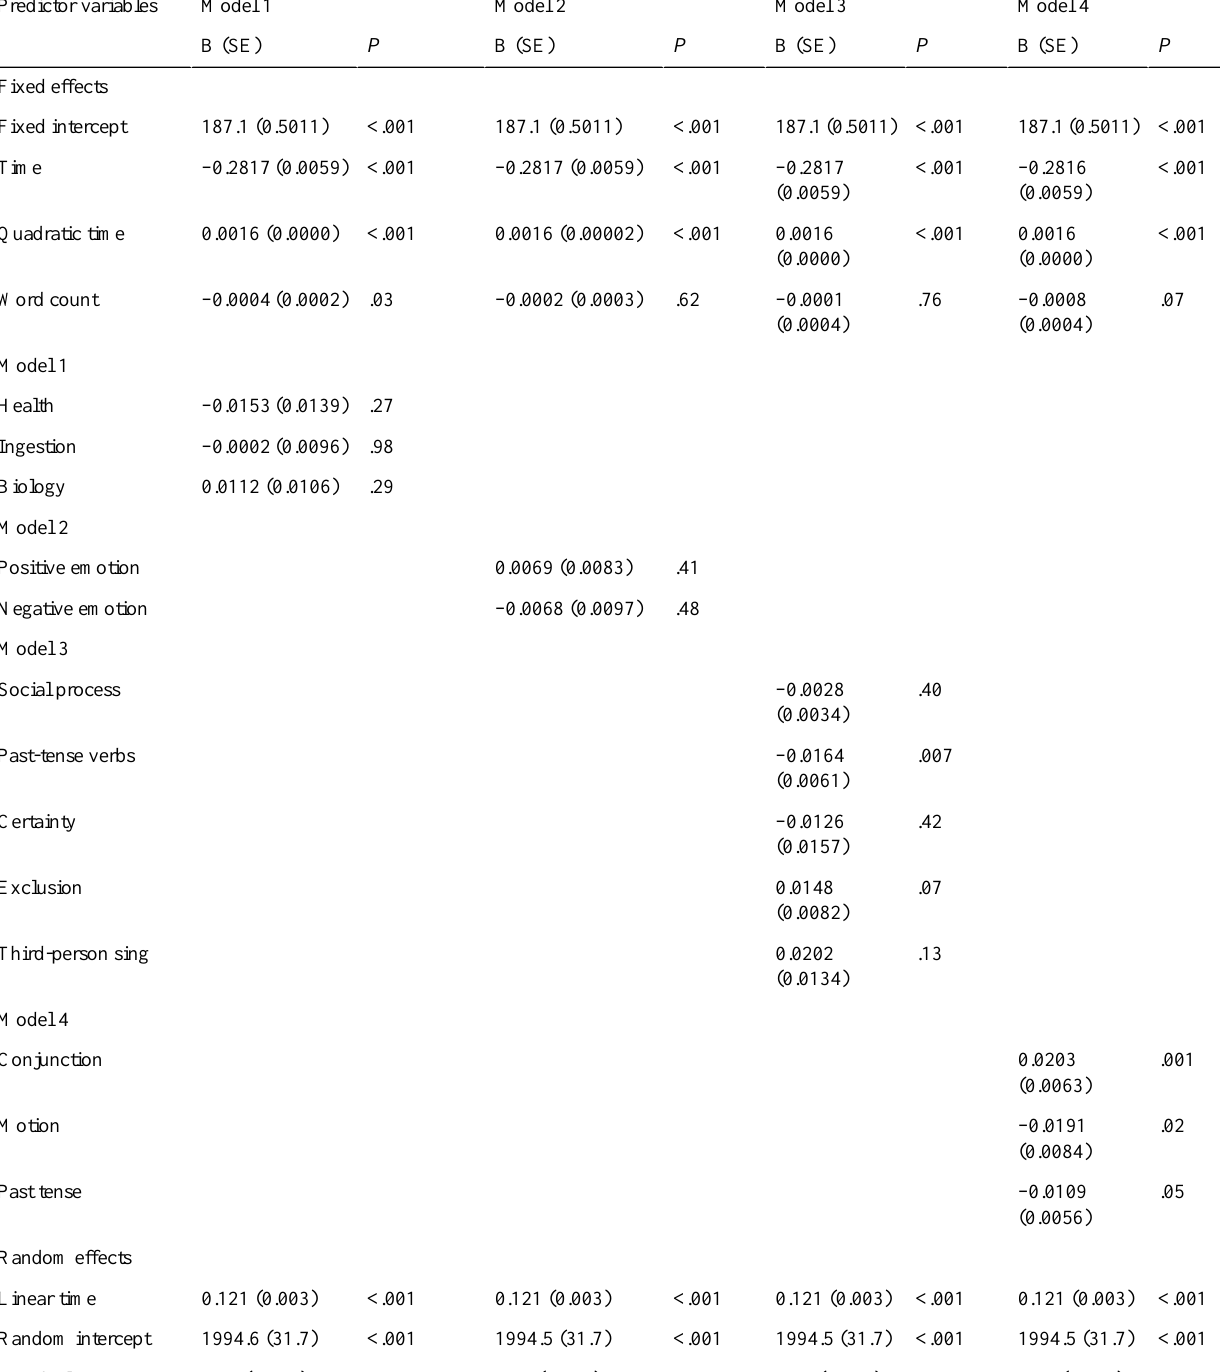
Table 3. Mixed models predicting weekly changes in